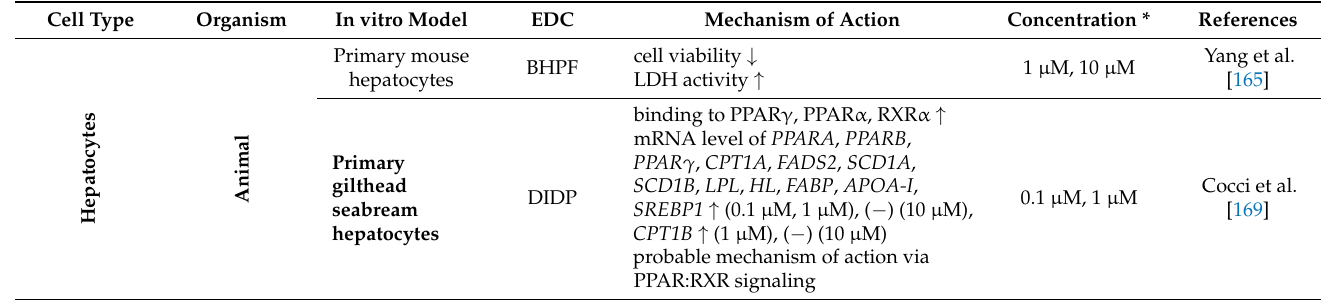
Table 3. The obesogenic effects of selected EDCs confirmed in hepatic cellular